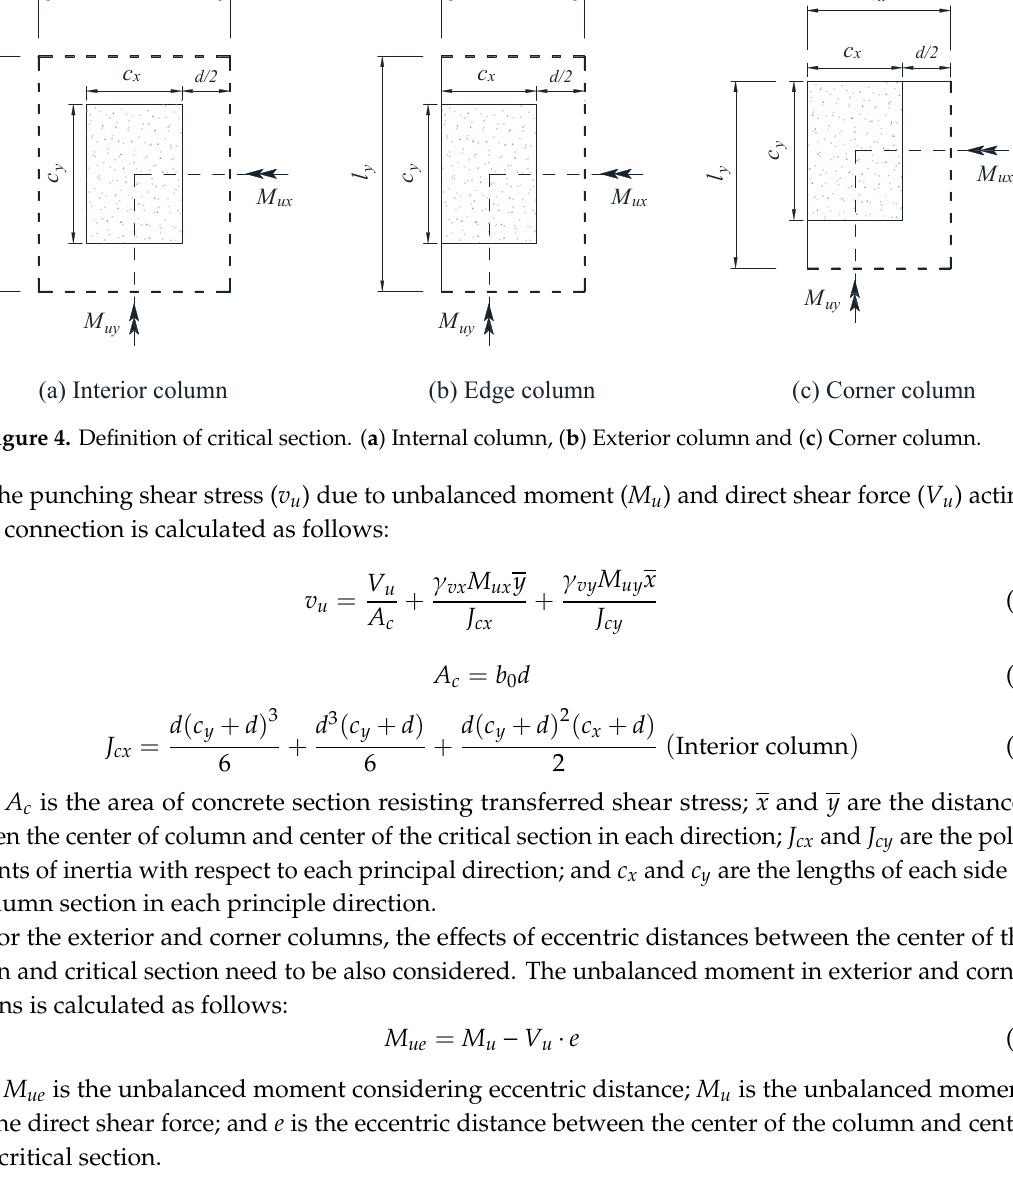
Figure 5. Calculation of direct shear and unbalanced moment at the slab-column connection.